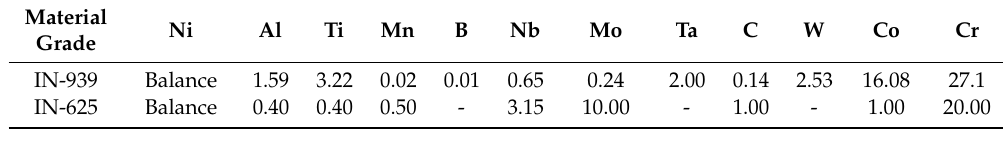
Table 1. Chemical composition of the base metal and filler metal (wt%).